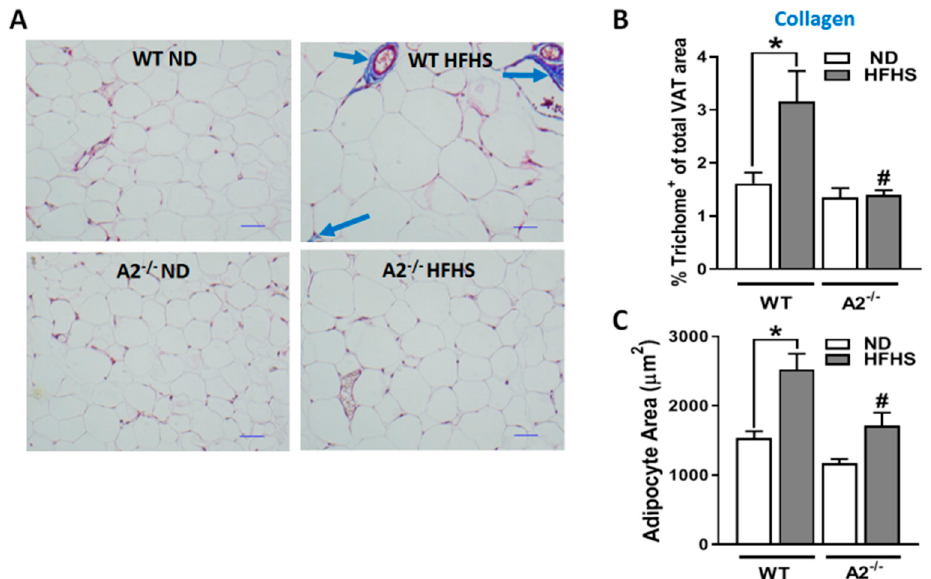
Figure 3. A2 deletion limits HFHS-induced VAT fibrosis and adipocyte hypertrophy. Representative photomicrographs of VAT show Masson’s trichrome staining of collagen/fibrosis depicted in blue color ( A ), Scale bar = 20 µ M and quantified as % of trichrome positive area to total VAT area ( B ). Quantification of HFHS diet-induced increases in adipocyte area is shown for WT and A2 − / − mice ( C ). Data are presented as mean ± SEM, n = 3–5 mice/group. * P < 0.05 when compared to ND-fed mice within the same genotype, # P < 0.05 when compared to WT on the same diet.